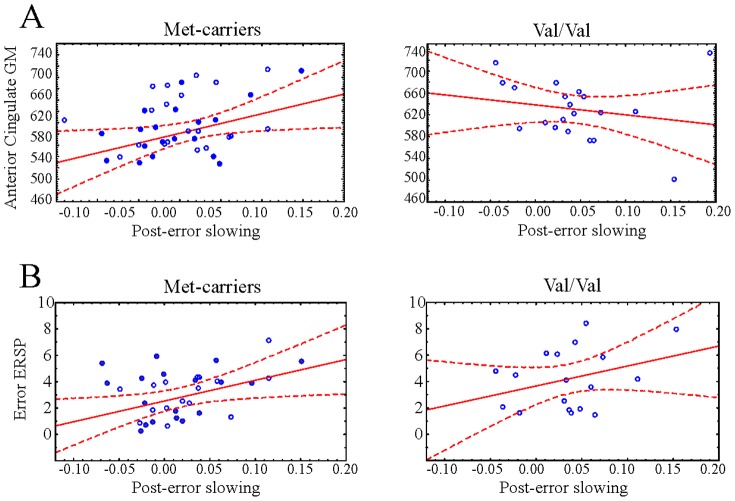
Correlations between grey matter and post-error slowing and between grey matter and ERSP.Panel A: Correlation between anterior cingulate grey matter volume and post-error slowing for met-carriers and Val/Val group. Met/Met subjects are filled dots, Val/Met subjects are empty dots in the Met-carriers plot. Dashed line indicates 95% confidence interval of the linear regression. Panel B: Correlation between error ERSP and post-error slowing, as above.